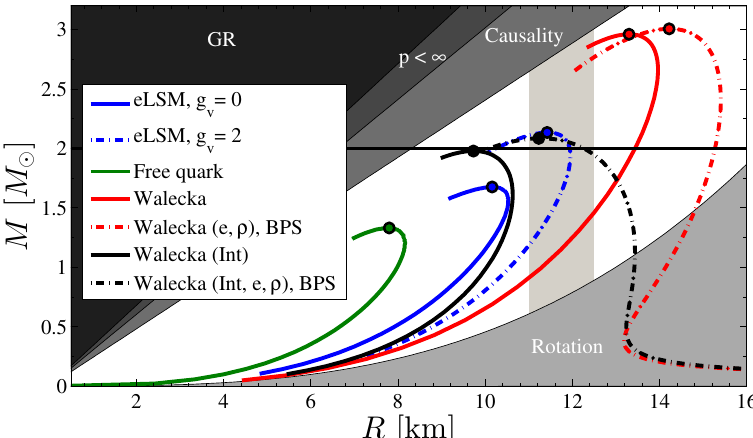
Figure 3. Mass–radius relations for the eLSM (blue solid line for g v = 0 and blue dashed–dotted line for g v = 2), the free constituent quark matter (green solid line), and the Walecka model for the various cases of Figure 1. The ends of the stable sequences of compact stars are marked by blobs. The observational constraint set by observed pulsars with masses of ∼ 2 M (cid:12) is represented by the black horizontal line, and the applied radius window of 11.0–12.5 km at 2 M (cid:12) is depicted by the vertical shaded area. The different shaded regions are excluded by the GR constraint R > 2 GM / c 2 , the finite pressure constraint R > ( 9/4 ) GM / c 2 , causality R > 2.9 GM / c 2 , and the rotational constraint based